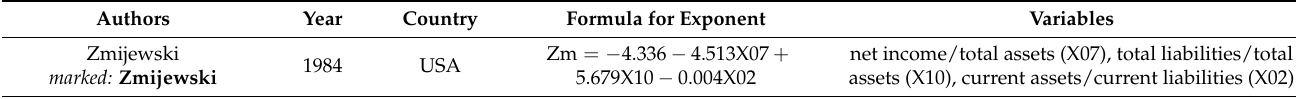
Table 8. The comparison of prediction models applied in V4